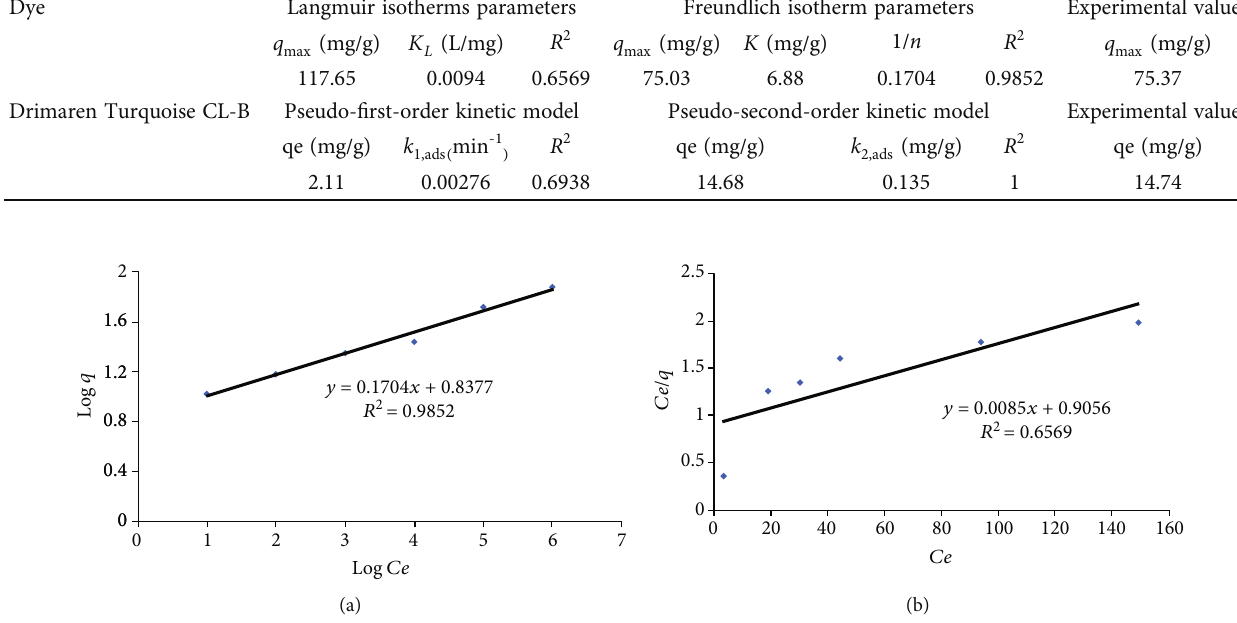
Figure 5: Adsorption isotherms. (a) Freundlich and (b) Langmuir for the removal of Drimaren Turquoise CL-B using S. commune